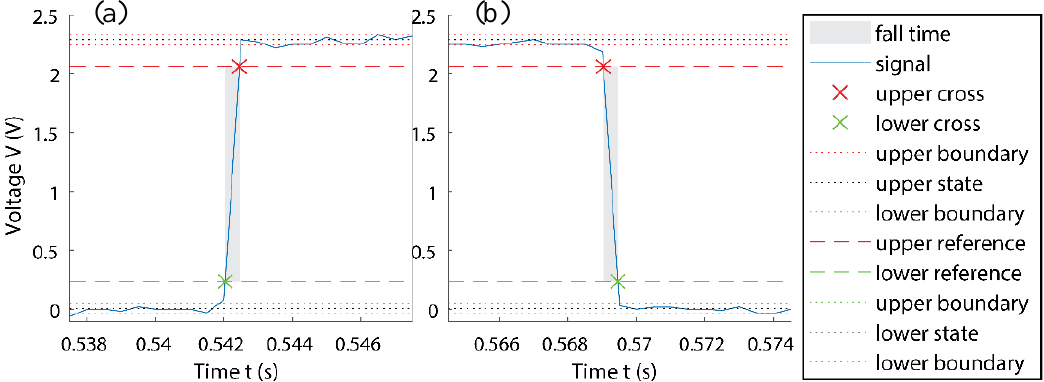
Figure 9. ( a ) Measured response time, ( b ) measured relaxation time.